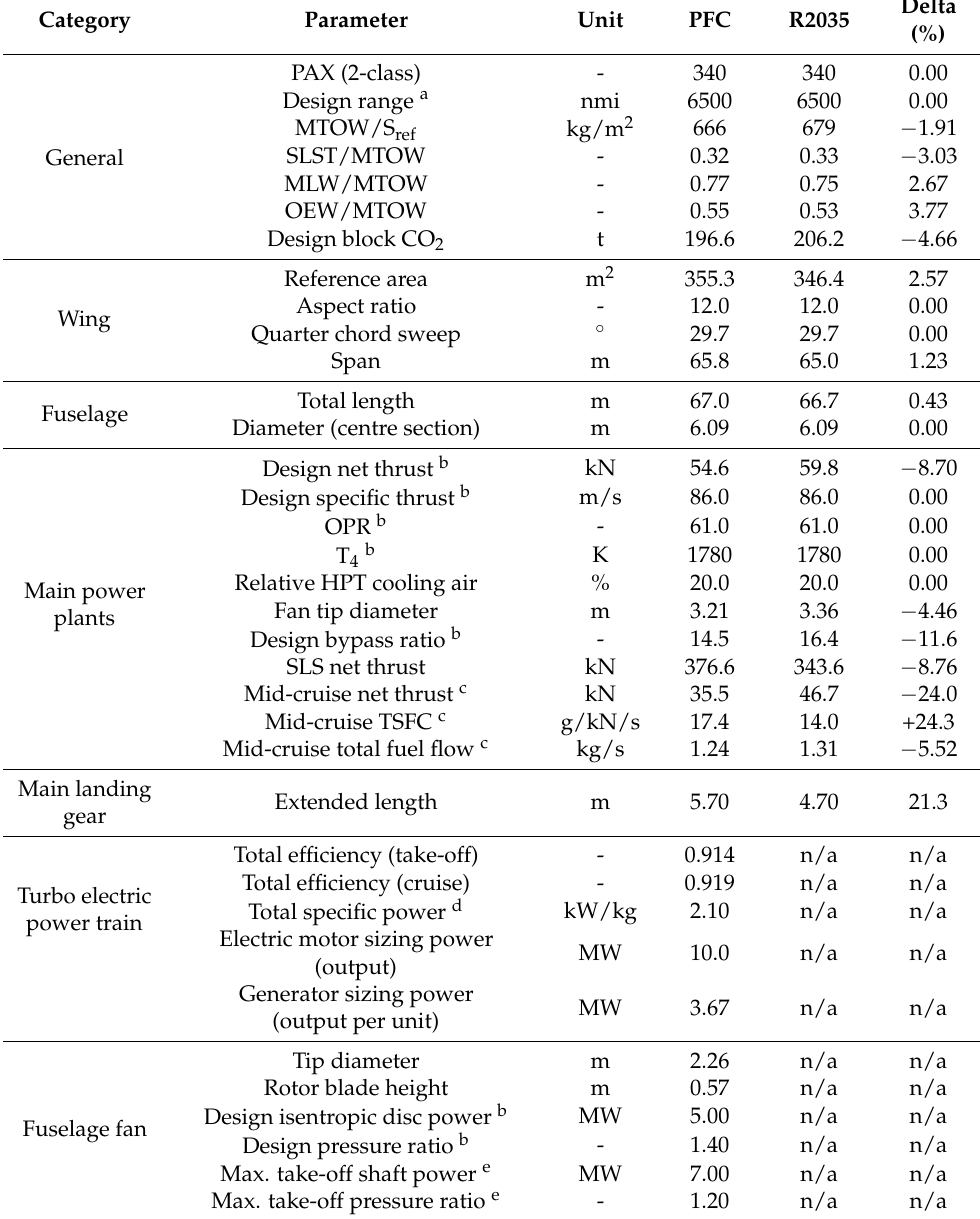
Table 15. Key design characteristics of the PFC and R2035 baseline